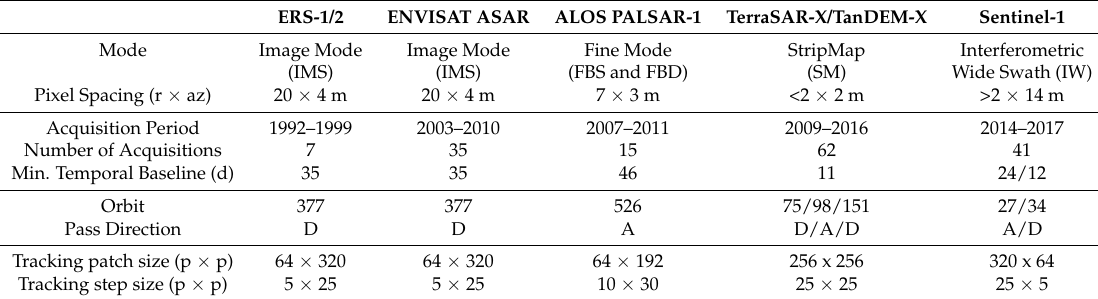
Table 1. Overview of the SAR sensor characteristics and the parameters used for the velocity tracking. The pass directions are abbreviated as A for Ascending and D for Descending. Pixel spacings in range (r) and azimuth (az) refer to the raw data and are approximate values. The tracking patch and step size are given in number of pixels